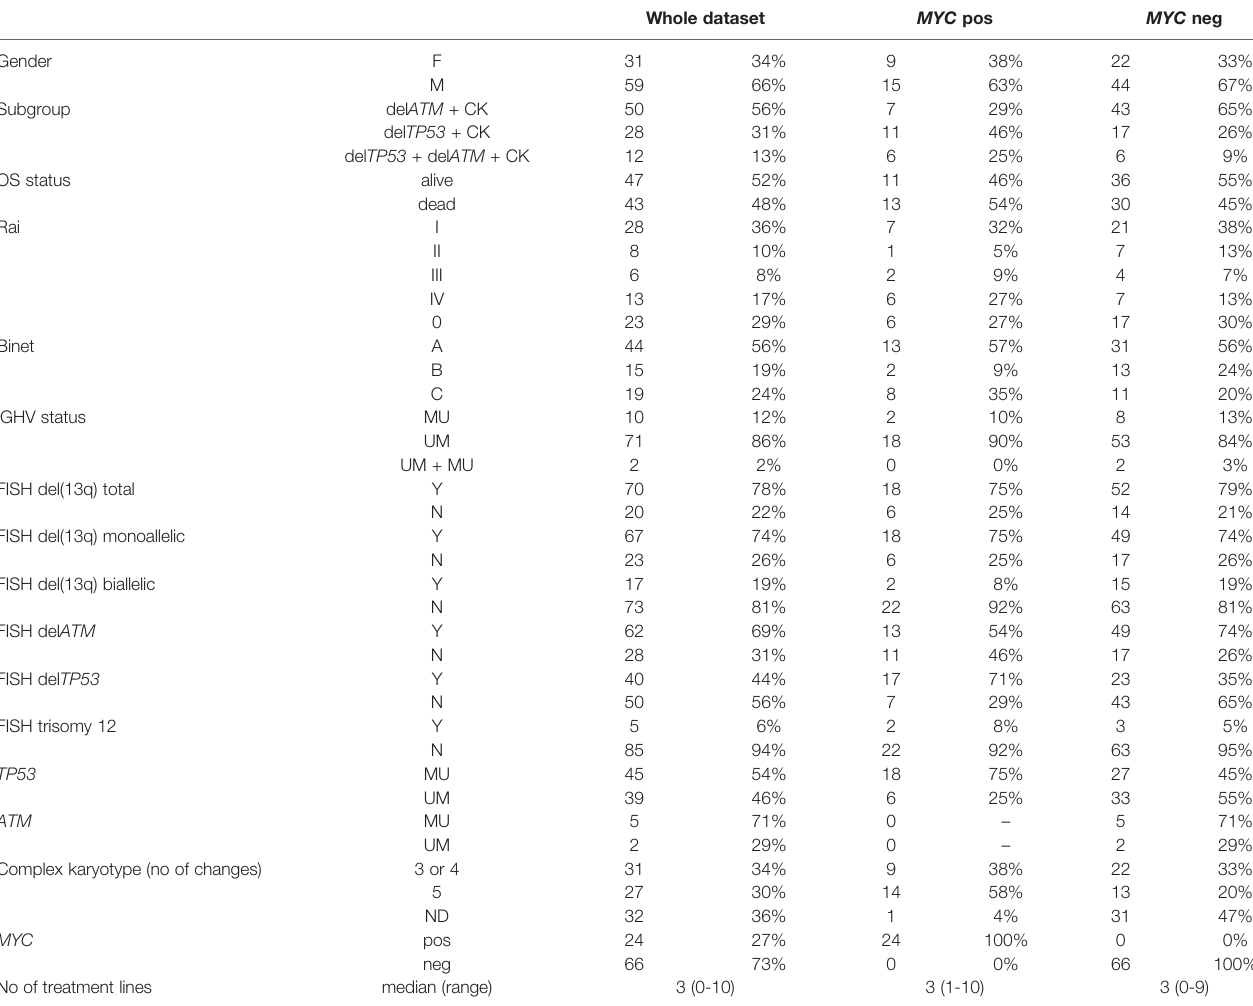
TABLE 1 | The characteristics of the analyzed cohort of 90 patients with